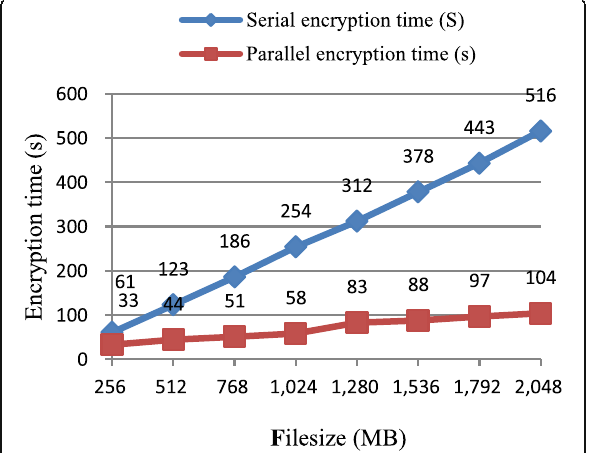
Fig. 2 The encryption time of different size file. The figure compares the encryption time under different file sizes in serial and parallel environments